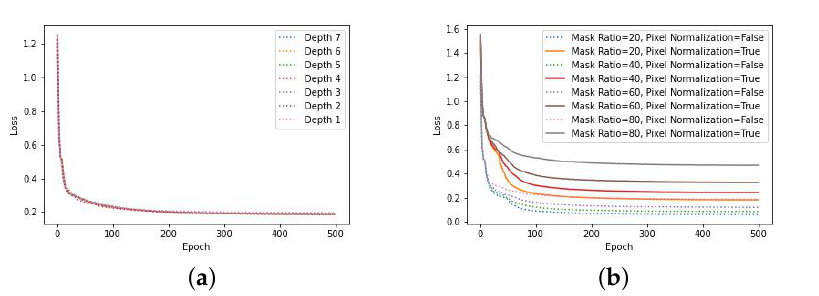
Figure 7. The pre-training loss curves. ( a ) The loss curves at different model depths, with a fixed mask ratio 0.8 and no pixel normalization. ( b ) The loss curves at different mask ratios and different approaches of pixel normalization, with a fixed depth 4.